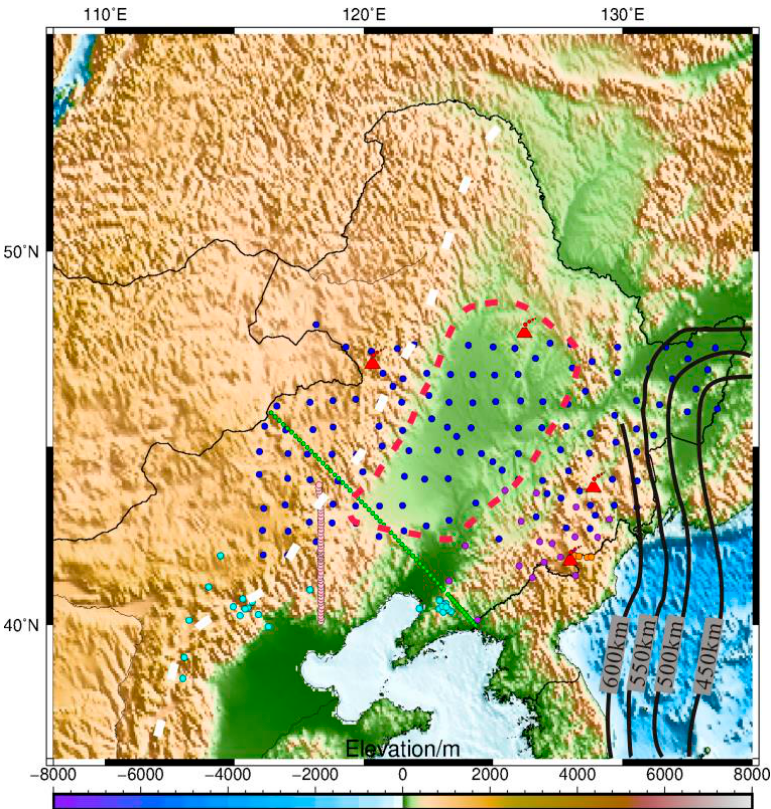
Figure 2. Station map and geological background selected in this paper. Appl. Sci. 2020 , 10 , x FOR PEER REVIEW